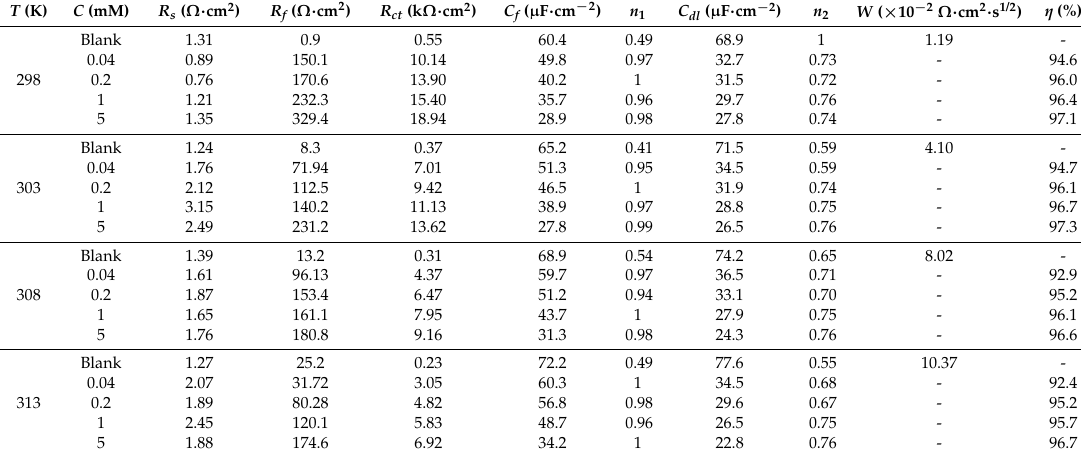
Table 2. Fitting EIS parameters of the Cu in 0.5 mol/L H 2 SO 4 at different temperatures with and without different concentrations of itraconazole.